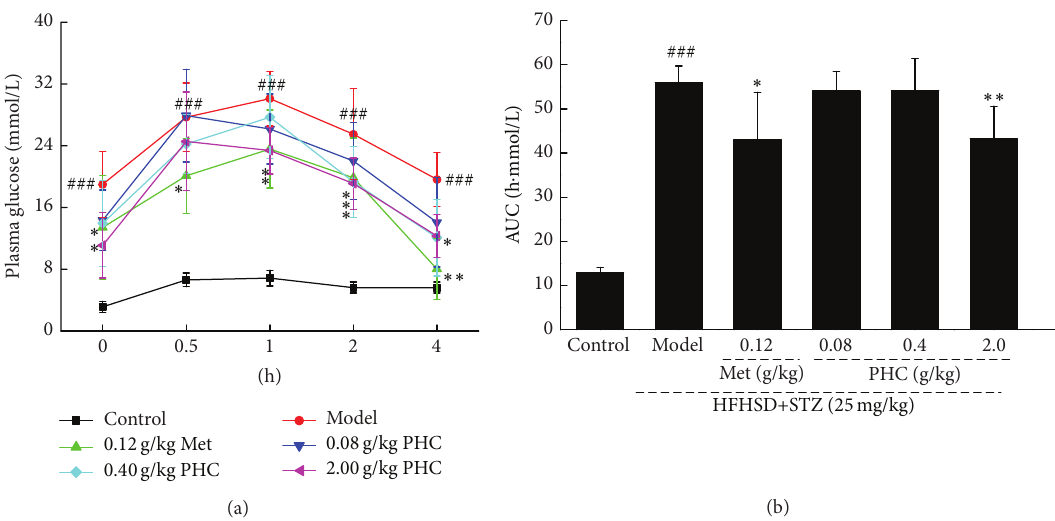
Figure 2: An oral glucose tolerance test was further performed to avoid a false positive result. After an oral administration of 2 g/kg D-glucose in all experimental rats, the changes of plasma glucose (a) and area under the curve of glucose (b) were analyzed. Data are expressed as mean ± SD ( 𝑛 = 10 ) and analyzed by using one-way ANOVA. ### 𝑃 < 0.001 versus control, ∗ 𝑃 < 0.05 and ∗∗ 𝑃 < 0.01 versus model group.